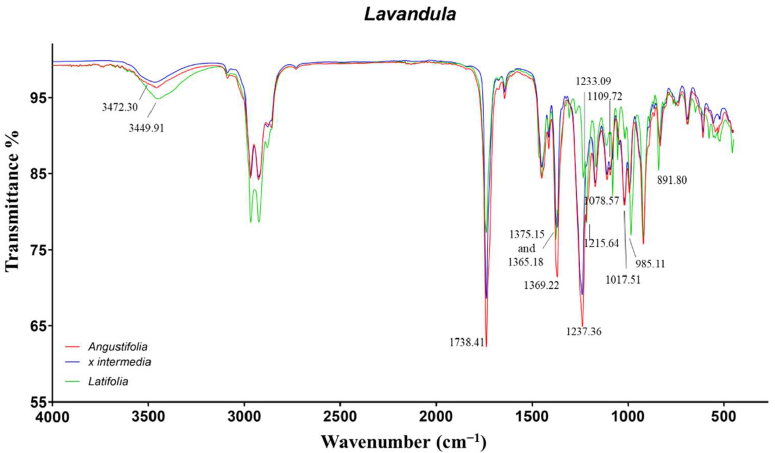
Figure 4. ATR-FTIR spectra of Lavandula angustifolia, Lavandula x intermedia, and Lavandula